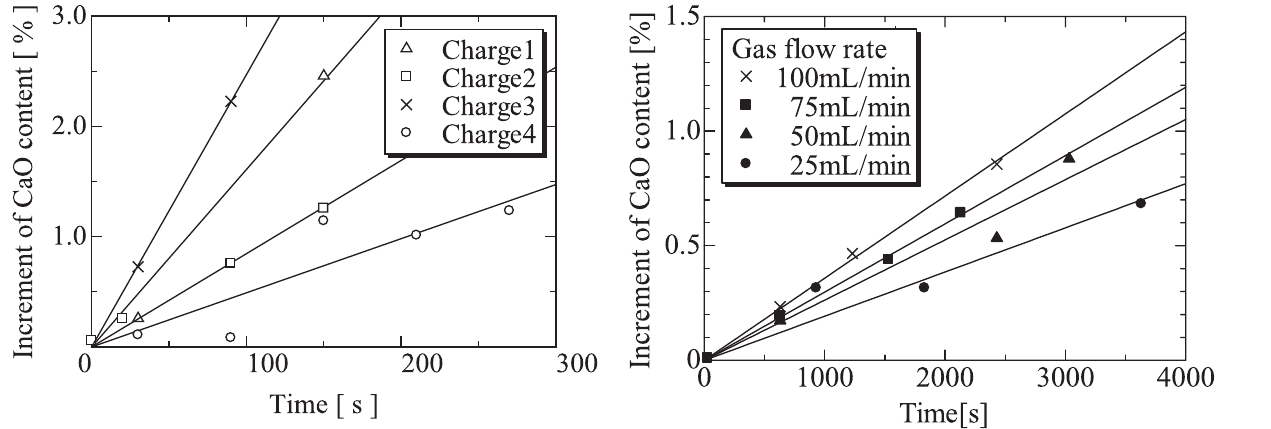
Fig. 8: Increment of CaO content when metallurgical lime (m-Lime) dissolved into 100 g of FeO-CaO-SiO